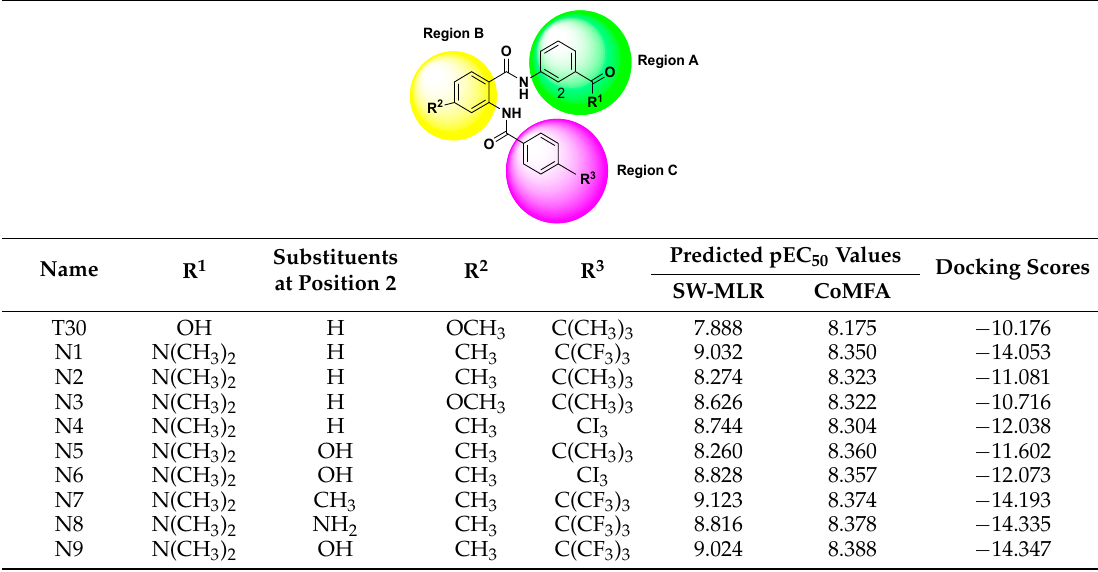
Table 6. Chemical Structures of Newly Designed partial FXR agonists based on 3D-QSAR Models.